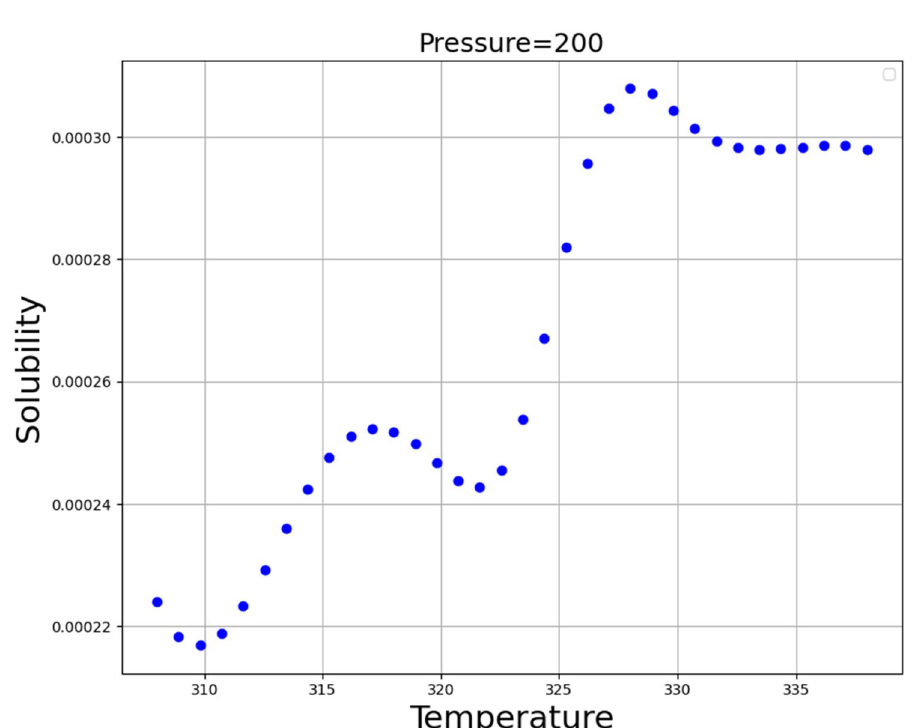
Figure 8. Solubility (mole fraction) base on temperature (°K), pressure